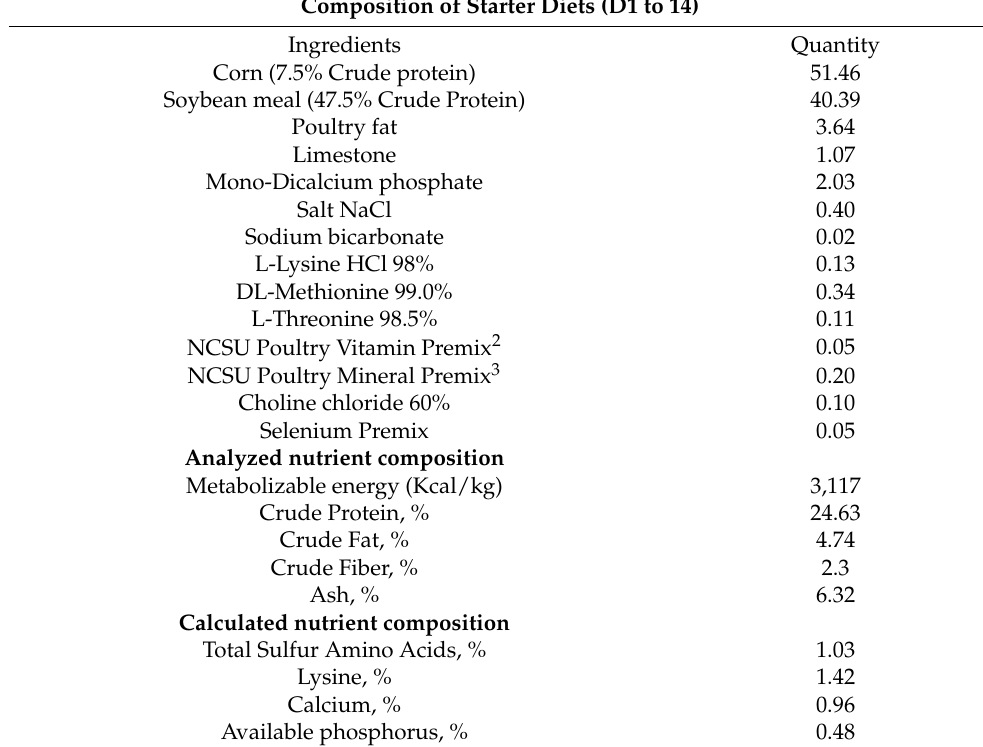
Table 4. Starter diet composition for the